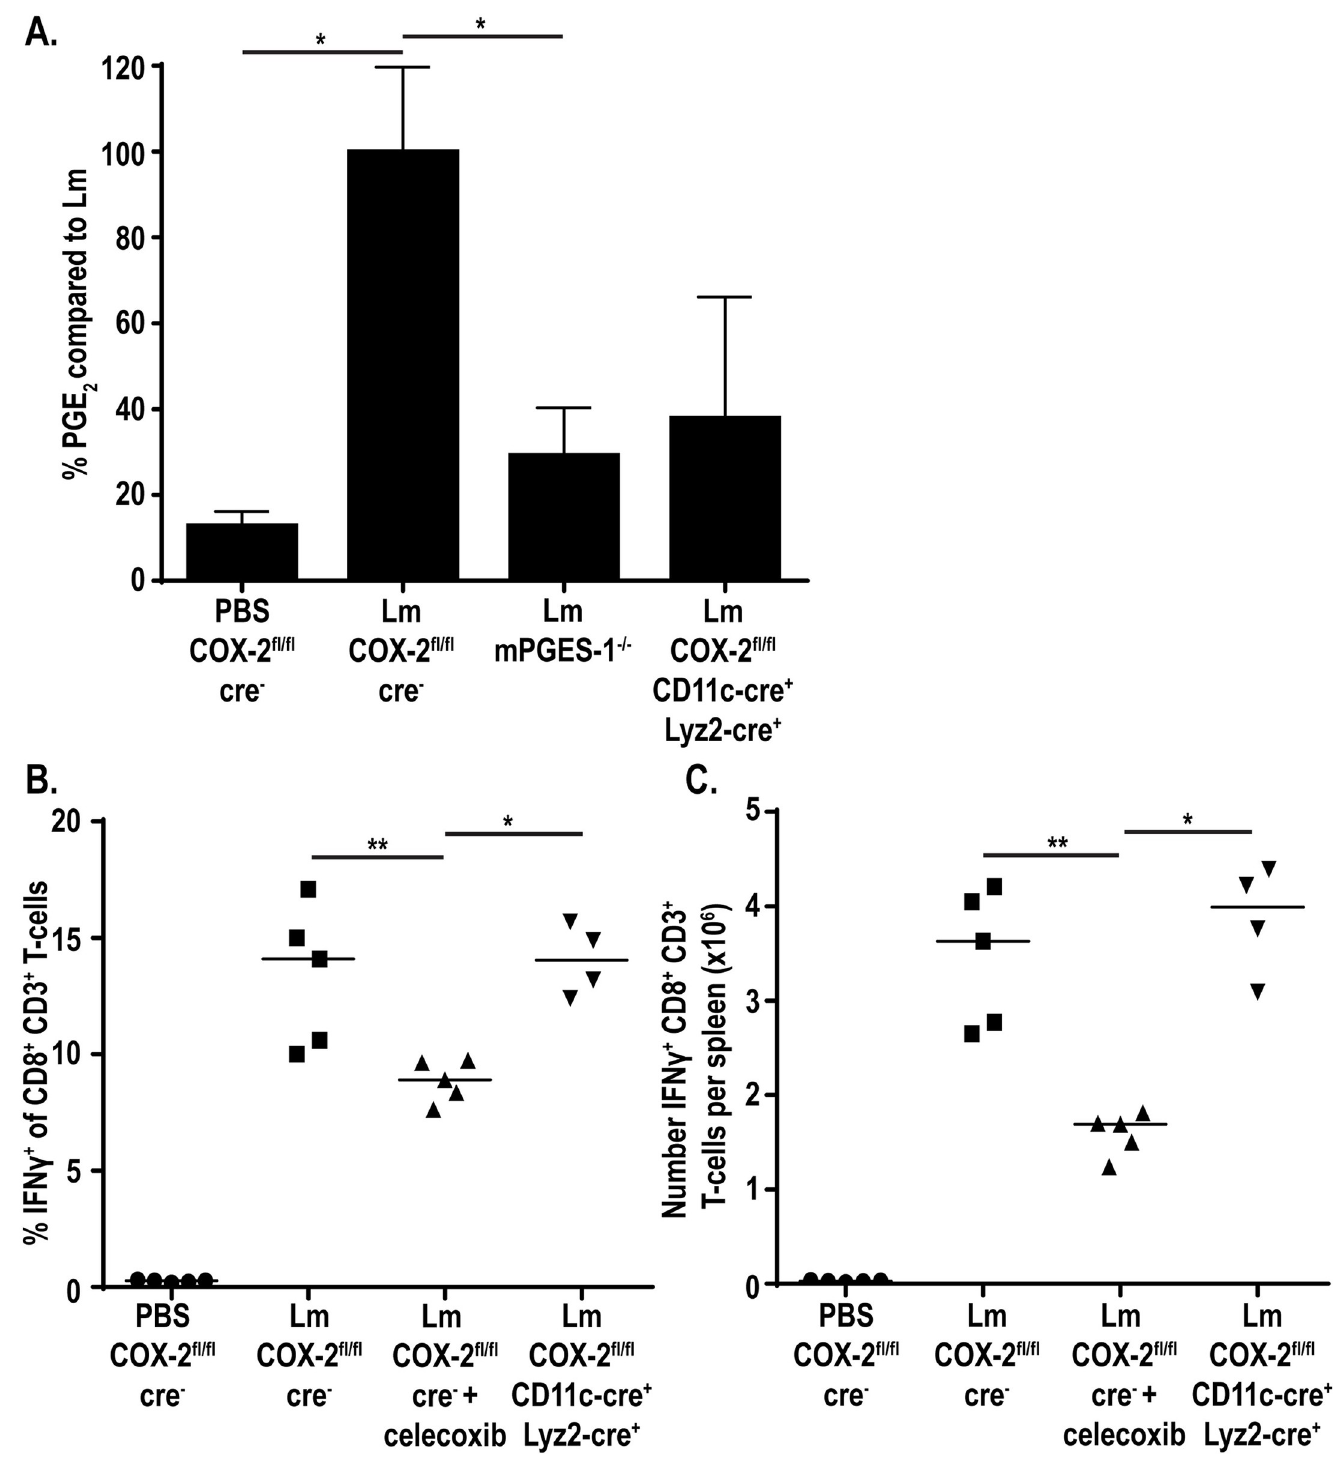
Fig 4. Deletion of COX-2 in both CD11c + and Lyz2 + cells further reduces PGE 2 production. Indicated strains of mice were infected with 10 7 LADD L . monocytogenes . 12hpi spleens were harvested and assessed for PGE 2 by mass spectrometry. Data was normalized to d-PGE 2 levels and percent change is compared to L . monocytogenes -infected controls (A). Indicated strains of mice were infected with 10 7 LADD L . monocytogenes . 7dpi splenocytes were examined for B8R-specific CD8 + T-cell responses. %IFN γ (B) or number IFN γ (C) per spleen was assessed. Data shown are representative of two independent experiments of 3–5 mice per group. Significance was determined by a one-way ANOVA with Bonferroni’s correction (A) or a Mann-Whitney U test (B-C). � p < 0.05, �� p < 0.01.